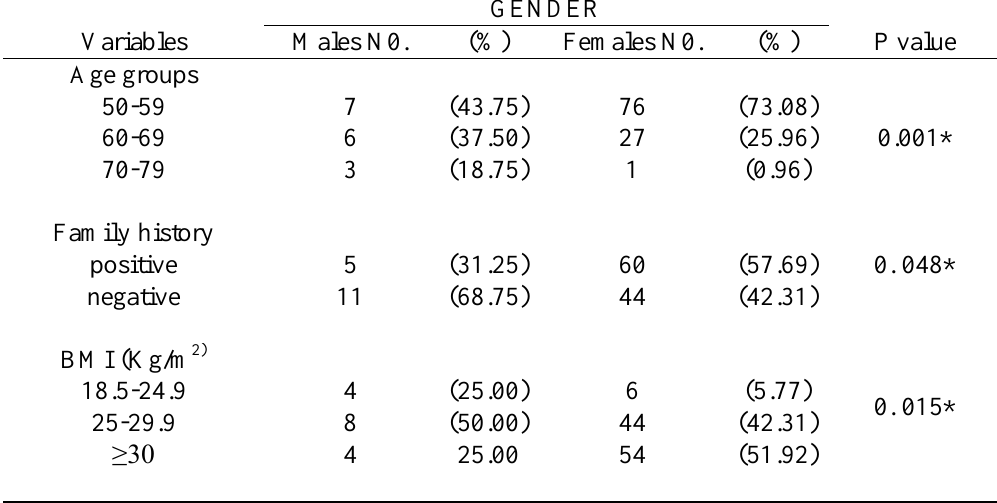
Table 1: Demographic characteristics of 120 knee osteoarthritis patients